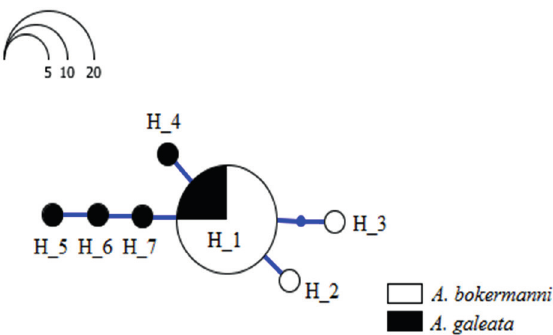
Figure 3 - Genotype network generated from the sequences of the MC1R generated in the present study for A. bokermanni and A galeata . The genotypes are represented by circles, the size of which is proportional to their frequency. The white shading represents the samples of A. bokermanni and black shading, the samples of A. galeata